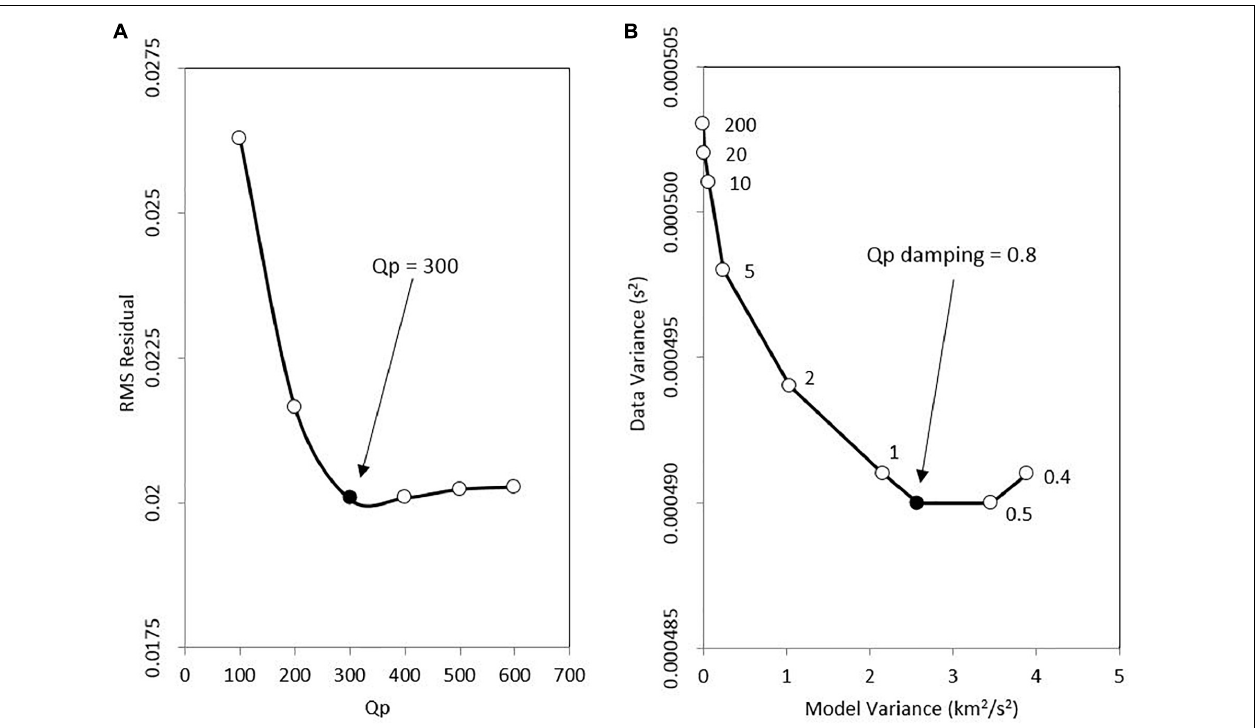
FIGURE 4 | (A) Initial constant Q p determined by the RMS of the attenuation operator t ∗ residual. The RMS reaches the minimum value at Q p = 300. (B) Trade-off curve between data misfit and model variance for attenuation inversion. The optimal damping parameter for Q p inversion is 0.8.